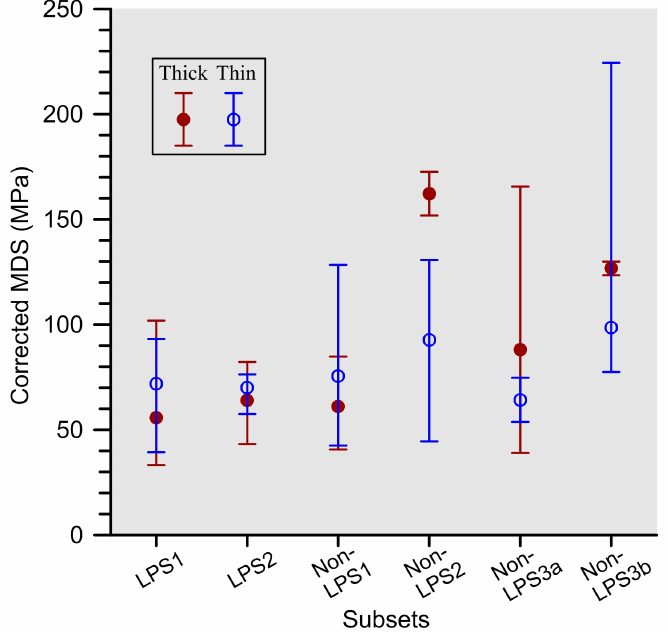
Figure 11. The range and mean value of the corrected (see [67]) maximum differential stresses (MDS) of each